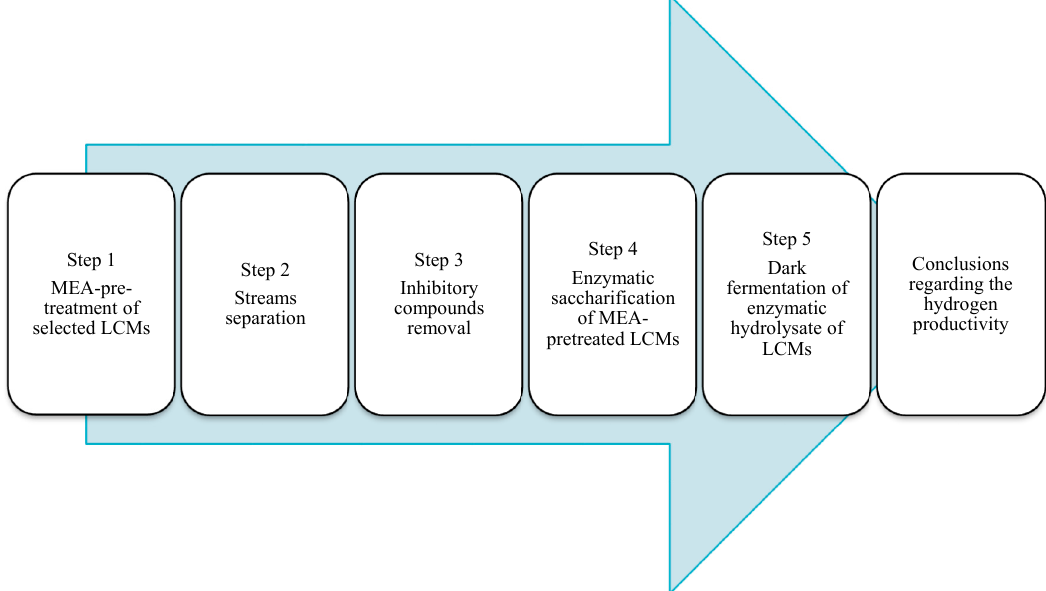
Figure 1. Design of the experiment